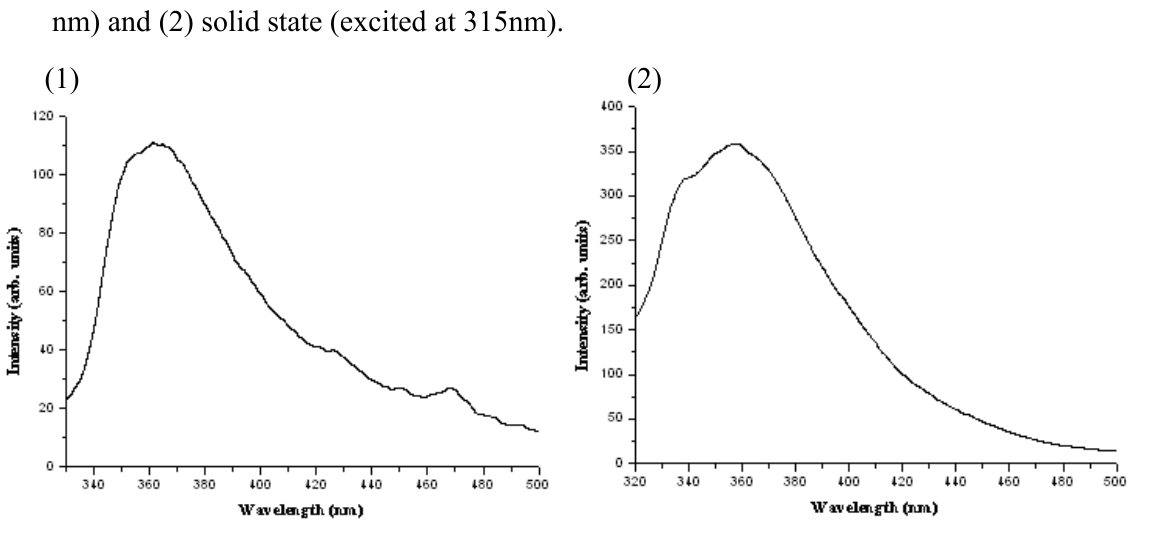
Figure 3. Field-emission SEM images of 4a supramolecular aggregates: a) overall sample morphology; b) a detailed view on a single